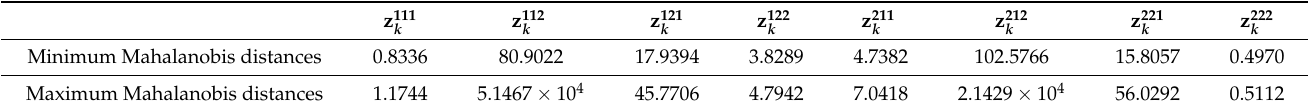
Figure 10. The initial estimate and the estimate after l iterations obtained using the stacked measure- ment vector z 212 . ( a ) Initial estimate. ( b ) Estimate after l iterations. k Table 1. Mahalanobis distances between the initial estimate and the iterative estimates.